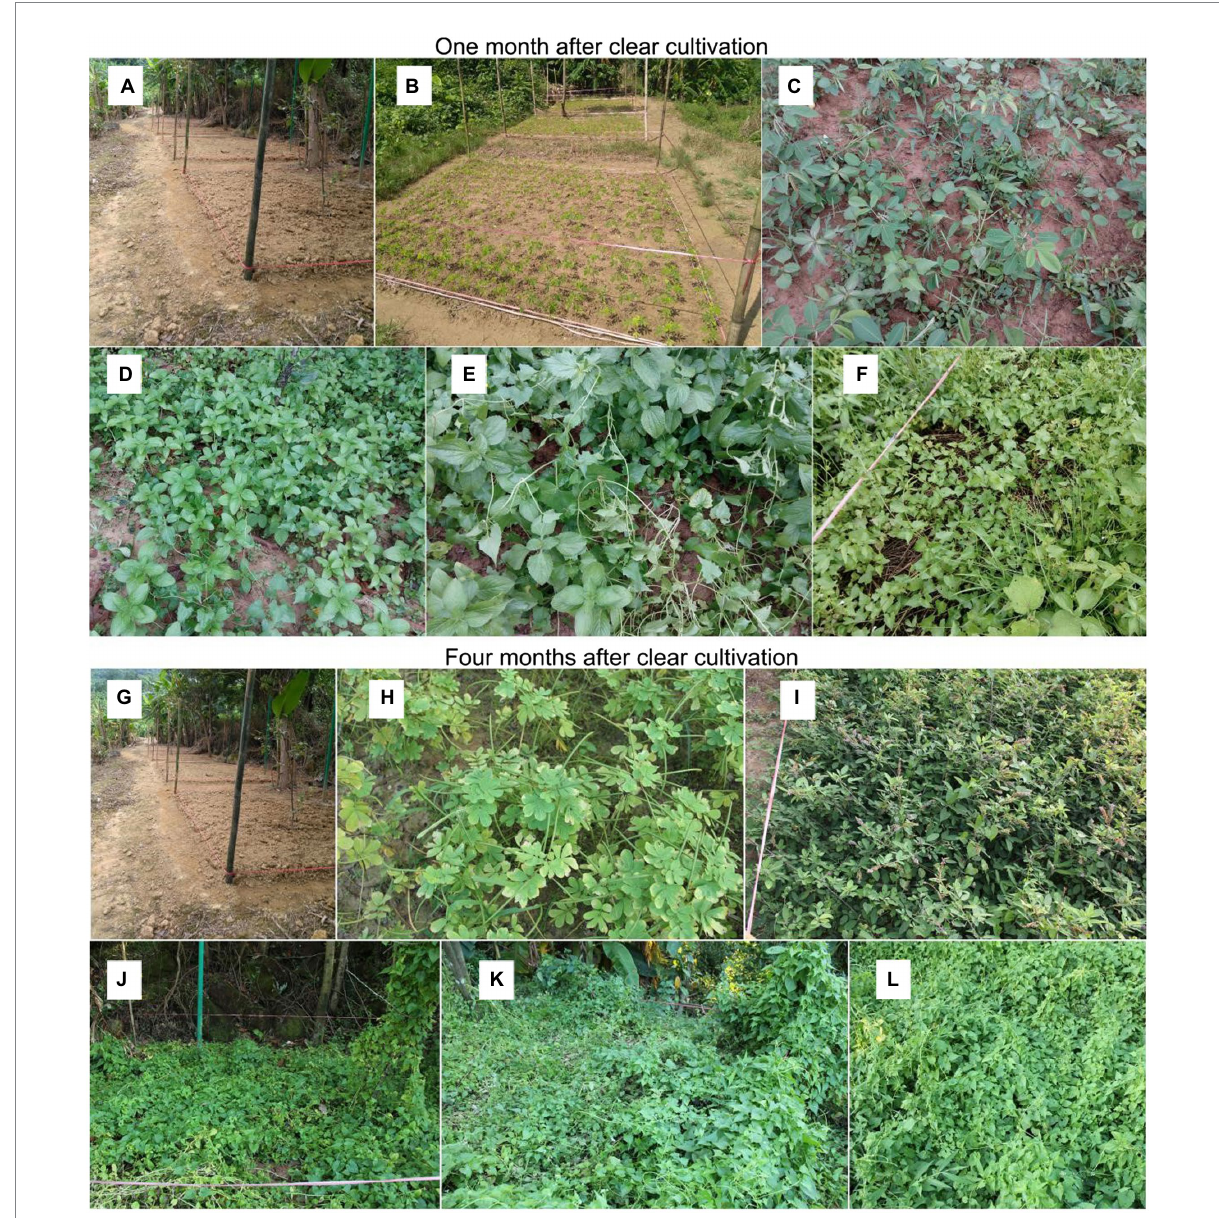
FIGURE 1 Growth status of four replacement plants after one and four months of clean tillage, respectively. (A, G) The original status after clean tillage; (B, H) S. tora ; (C, I) D. heterocarpon ; (D, J) S. latifolia ; (E, K) A. conyzoides ; (F, L) M. micrantha naturally regenerated as the